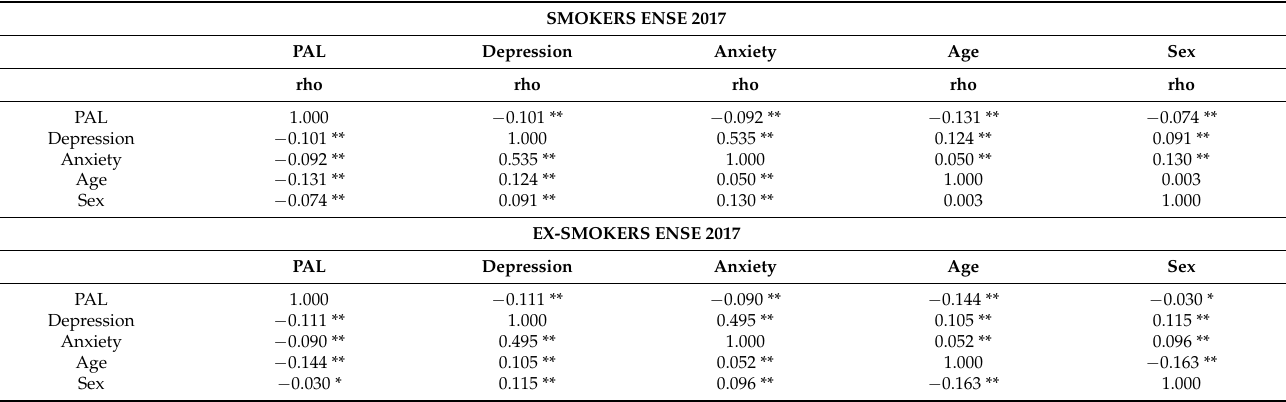
Table A8. Spearman’s bivariate correlation between physical activity level (PAL), prevalence of depression and anxiety, age and sex: ENSE